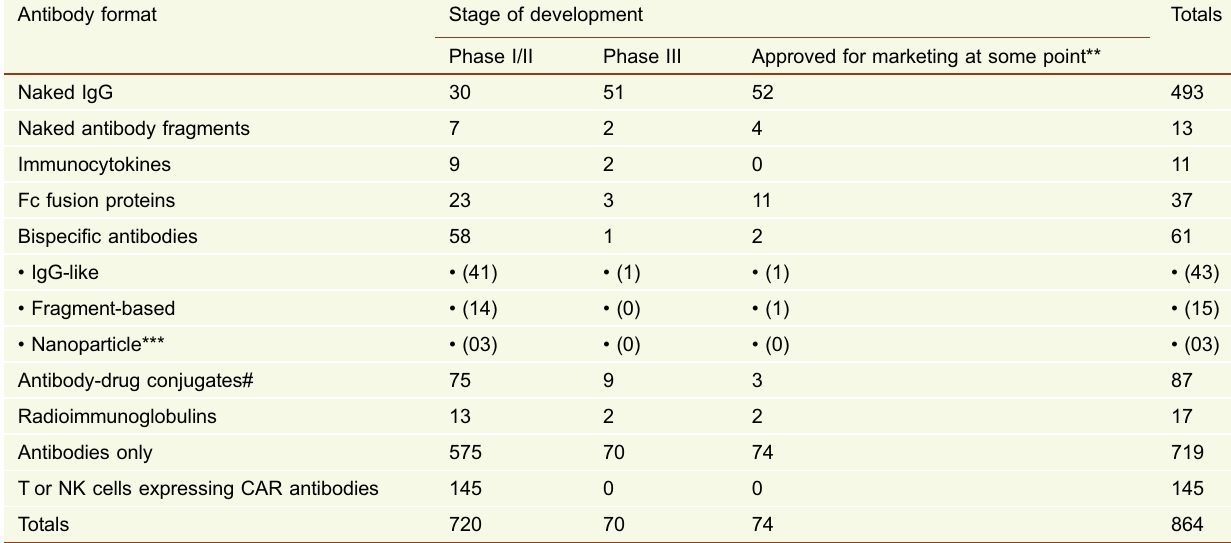
Table 3. Current status of innovative antibody, Fc fusion protein, and chimeric antigen receptor (CAR) drug candidates* Antibody